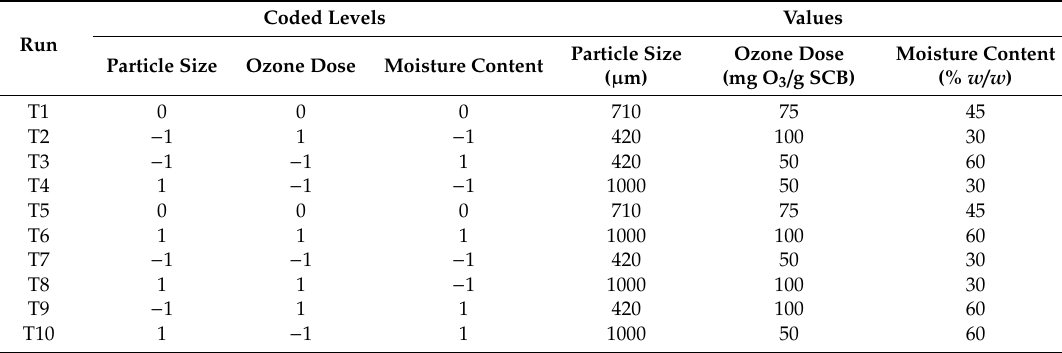
Table 1. Experimental design for the ozonation of sugarcane